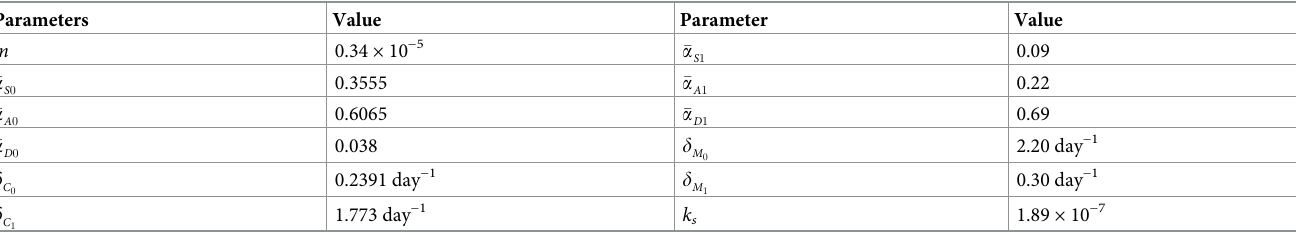
Table 3. Values of the parameters used in Fig